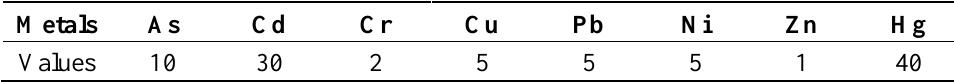
Table 2. Toxicity factors of heavy metals.